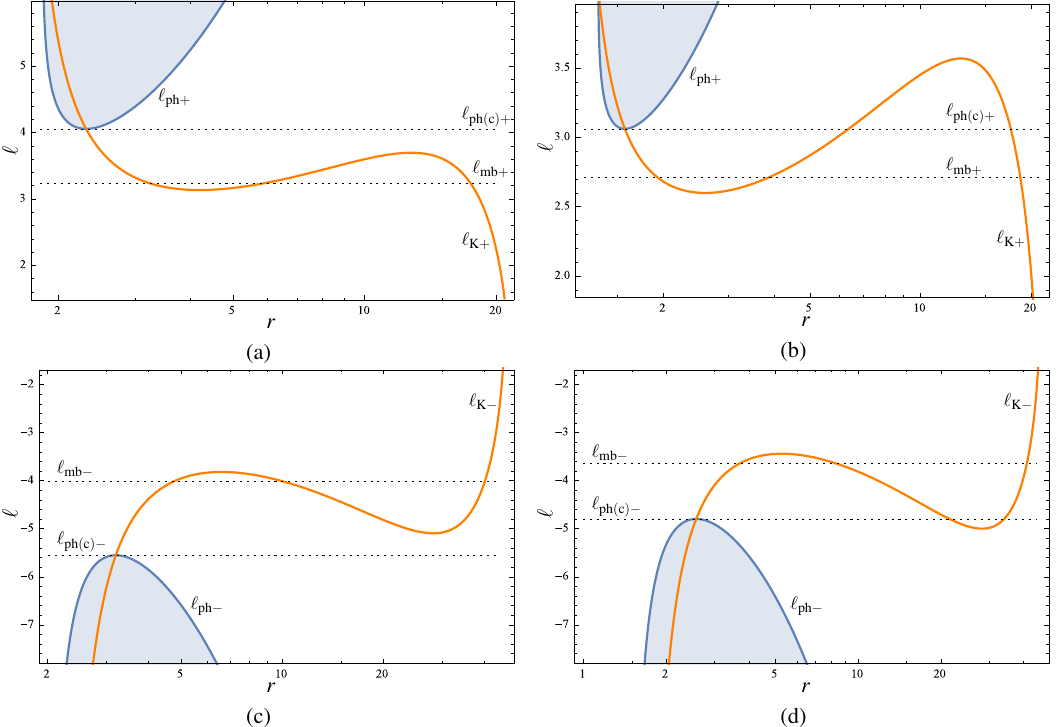
Figure 6. Keplerian specific angular momentum (orange curve) and effective potential of the photon geodesic motion (blue curve) of the Kerr–de Sitter black-hole spacetimes. In sub-figures (a-b) y = 10 − 4 and in (c-d) y = 10 − 5 , the rising (descending) part(s) of (cid:96) K + and the descending (rising) part(s) of (cid:96) K correspond to the stable (unstable) orbits. The local extrema of the functions (cid:96) K angular momentum of marginally stable orbits—the inner and the outer, (cid:96) ms ( i ) and (cid:96) ms ( o ) . The local extreme of the photon potential determines the impact parameter of the photon circular geodesic, (cid:96) ph ( c ) . Values of local extrema of both functions depend on spacetime